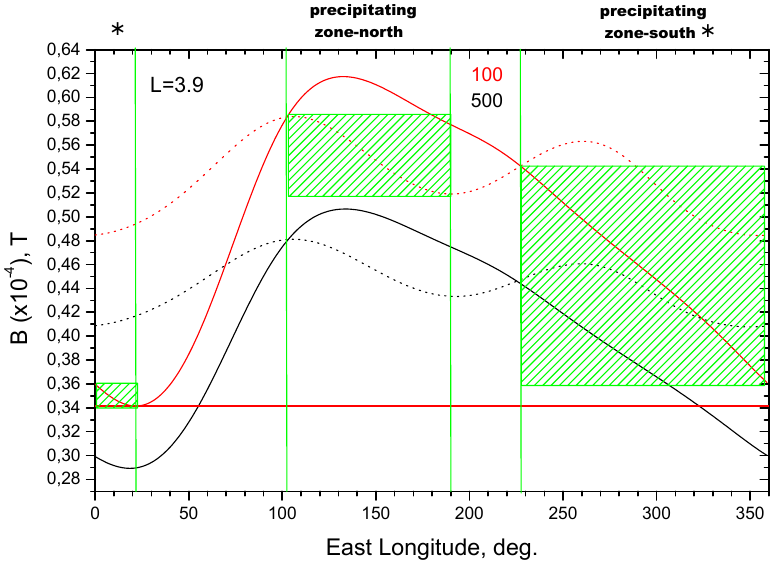
Fig. 8. The longitude intervals of the southern and northern precipitation zones at L = 3 . 9 are indicated by green dashed areas. The remaining graphics have the same meaning as in Fig.